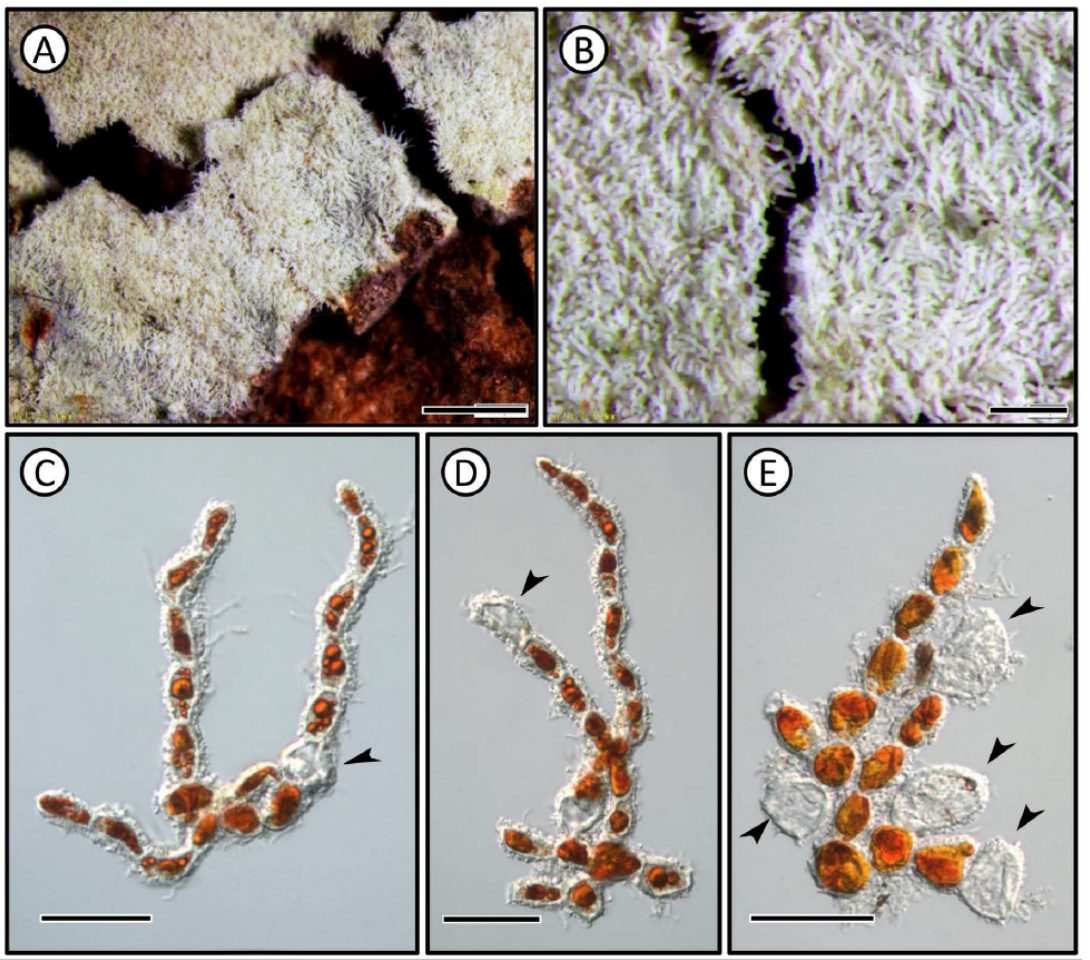
Figure 1. Morphology of Trentepohlia odorata . A – B , steroscopic view of Trentepohlia odorata specimen (preserved in Formol acetic alcohol solution) on surface of Fagus longipetiolata . C , microscopic view of heterotrichous thallus and its intercalary zoosporangium (arrow). D , the apical zoosporangium with a dorsal pore (arrow). E , the lateral zoosporangia with dorsal pore in cluster (arrows) at the basal part of thallus. Scale bars, 1 mm in A , 200 μm in B , 30 μm in C – E .